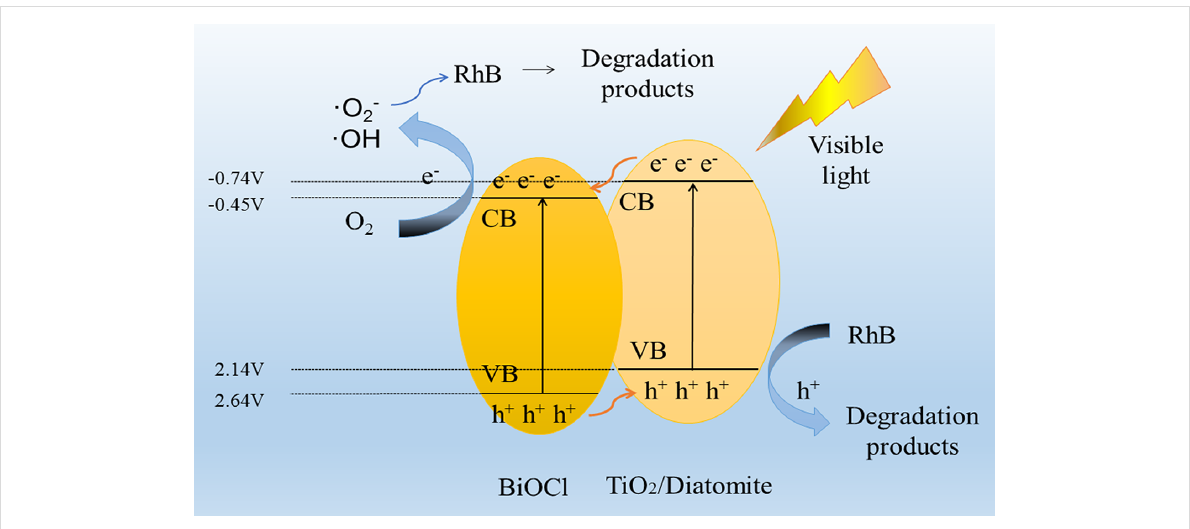
Figure 11: Photocatalytic mechanism of the BTD composite under visible-light irradiation to degrade